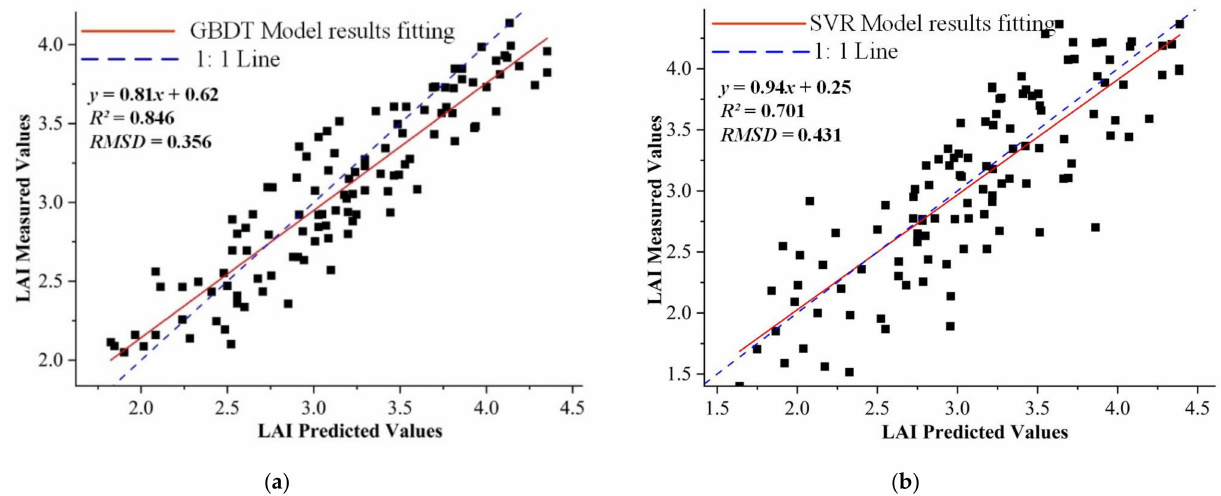
Figure 8. Regression lines between the measured and predicted LAI values for the shoot-stopping stage: ( a ) results of the GBDT model; ( b ) results of the SVR model.